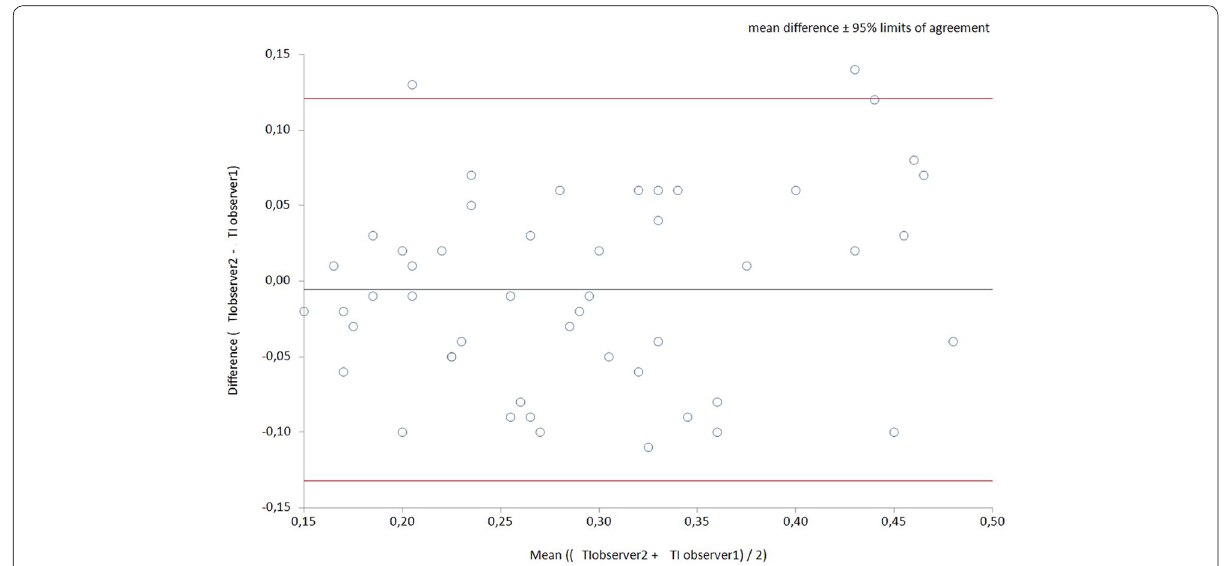
Fig. 1 Bland–Altman method for interobserver difference in TI